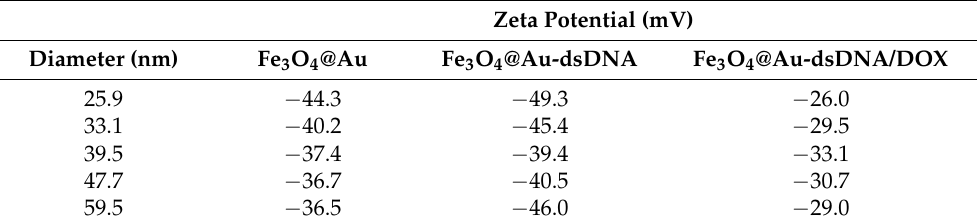
Table 2. Zeta potential of different Fe 3 O 4 @Au NP, Fe 3 O 4 @Au NP-dsDNA, and Fe 3 O 4 @Au NP- dsDNA/DOX sizes.